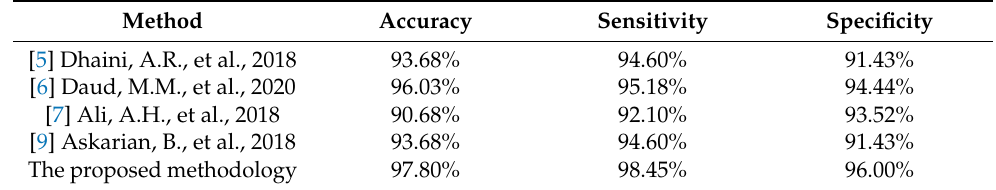
Table 7. Comparison of results of the convolutional neural network (CNN) for Keratoconus classi- fication and our proposed CNN, using k-Fold Cross-Validation, k = 10: training set (80%), testing set